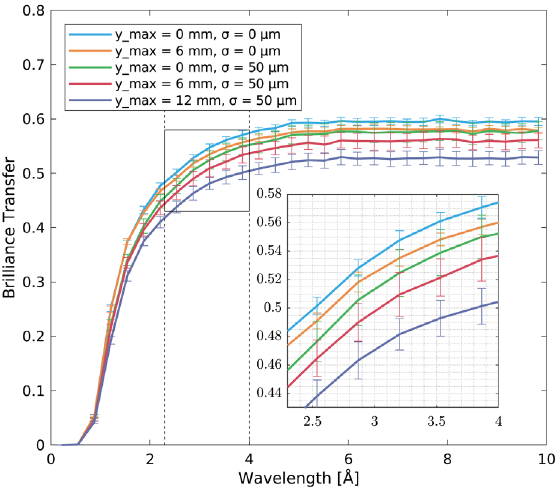
FIG. 9. Brilliance transfer as a function of wavelength for the BIFROST guide with model 3. The blue curve is the ideal guide. The dotted, vertical lines show the wavelength band 2.3 – 4.0